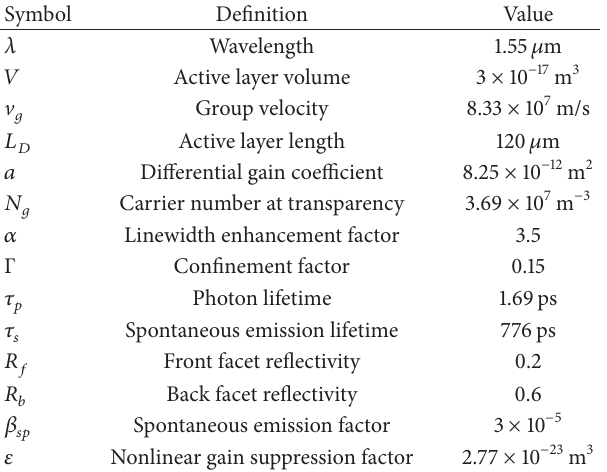
Table 1: Definition and numerical values of the solitary high-speed laser parameters.